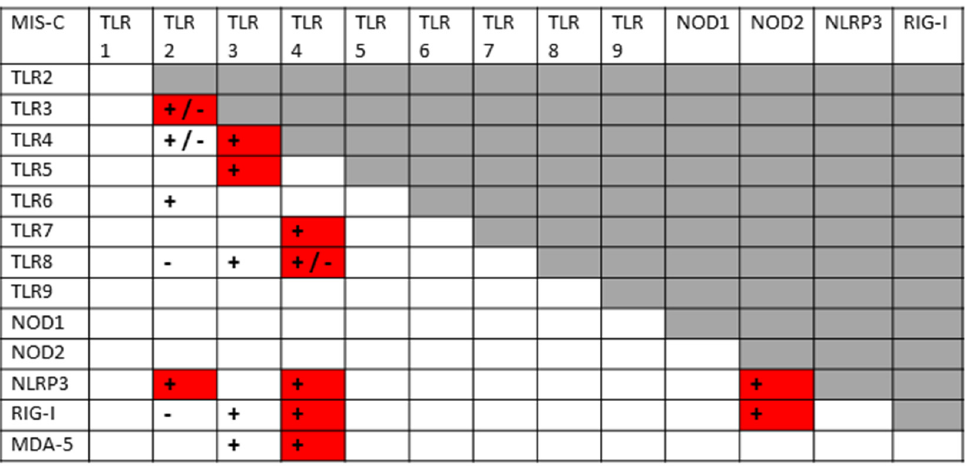
Figure 6. Predicted synergisms (+) and antagonisms ( − ) resulting from multisystem inflammatory syndrome in children (MIS-C) activation of innate receptors resulting from mapping Figure 3 (literature review of innate receptor activation) onto the template provided by Figure 2 (summary of known innate receptor synergisms and antagonisms). Red entries indicate extracellular (“bacterial antigen”) receptor synergisms with intracellular and endosomal (“viral antigen”) receptors.